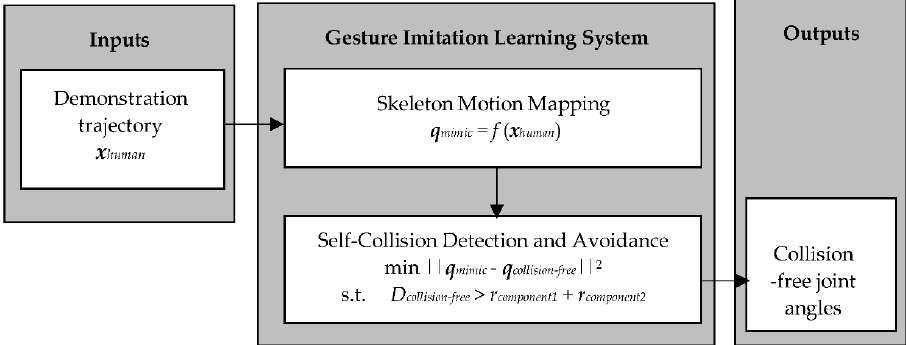
Figure 1. Diagram of the gesture imitation learning system.